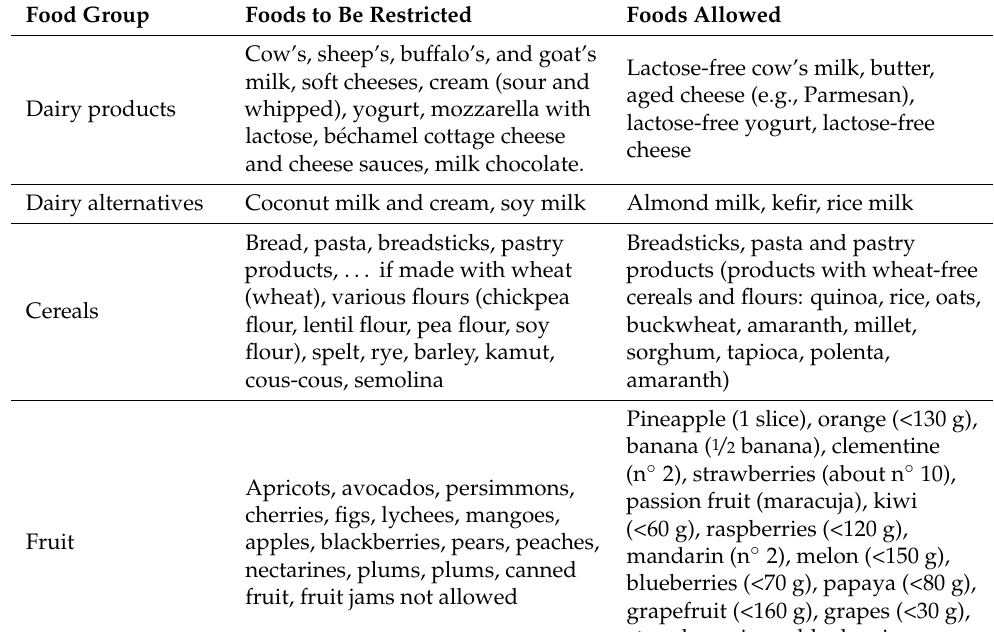
Table 1. Low- FODMAP protocol proposed to our FD GI symptomatic patients, and then retrospec- tively analysed in this